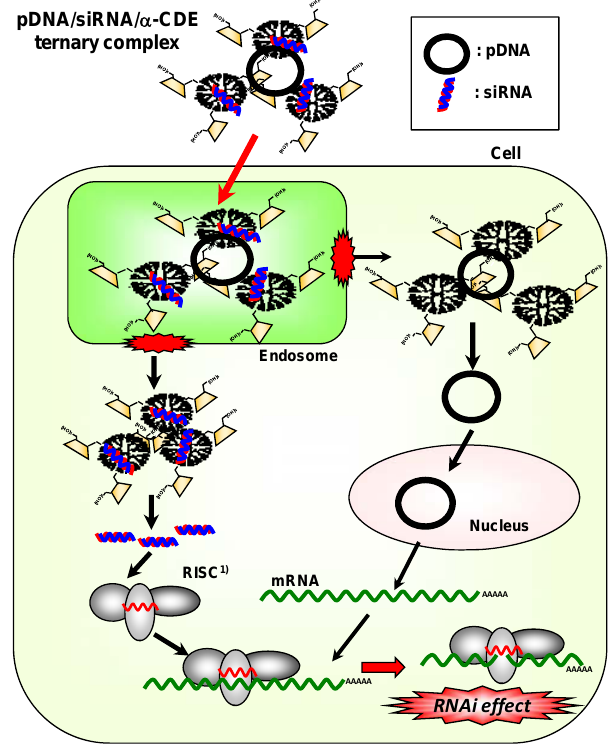
Figure 3. Proposed scheme of RNAi effects of the ternary complexes of pDNA/siRNA/ α